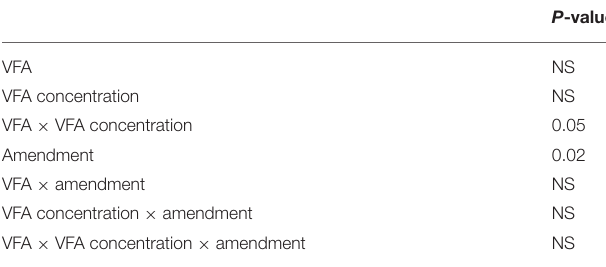
TABLE 3 | Analysis of variance for response variables of Trichoderma spp. populations in experiment 2 as affected by the main effects of volatile fatty acid (VFA), VFA concentration, ASD soil amendment, and their